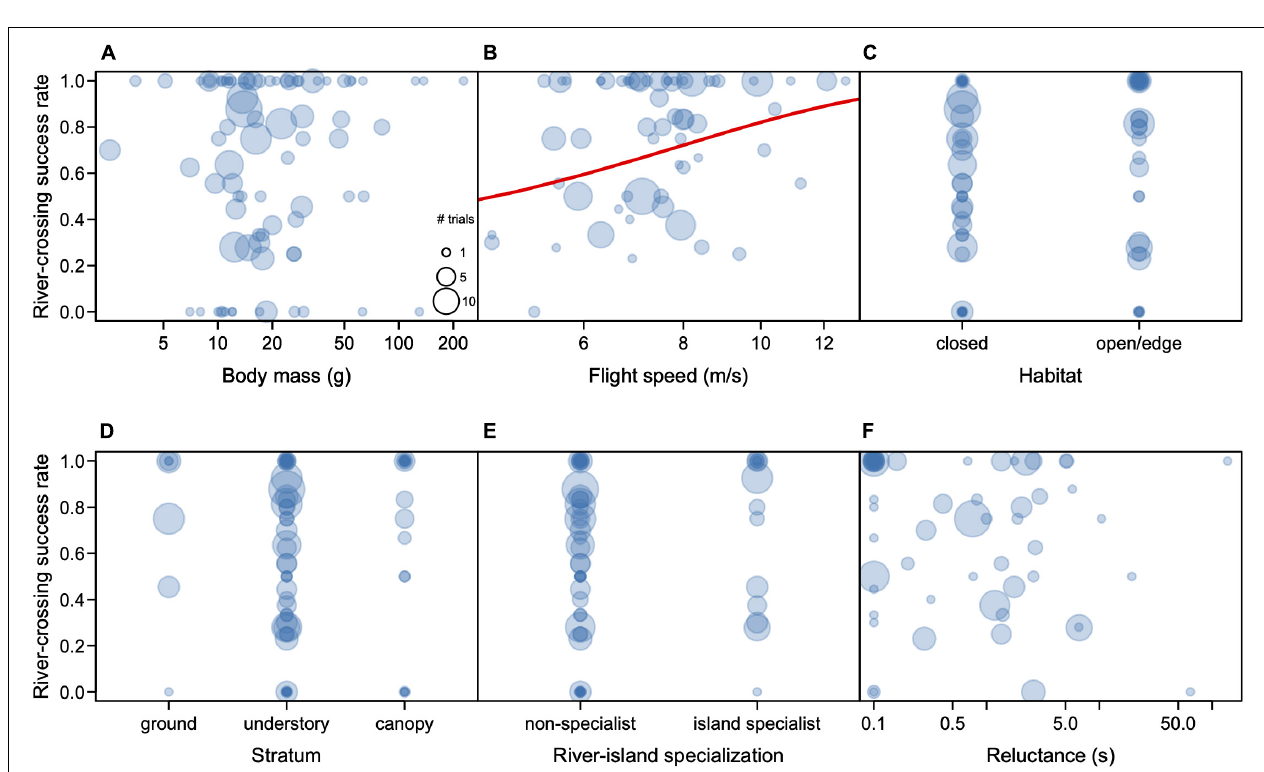
the experiments can be considered river-island specialists at our study site ( Table 1 ). We found a significant effect of forest stratum preference on river-crossing success ( R 2 = 0.052, F = 4.2, p = 0.029) ( Figure 3D ), but not on habitat